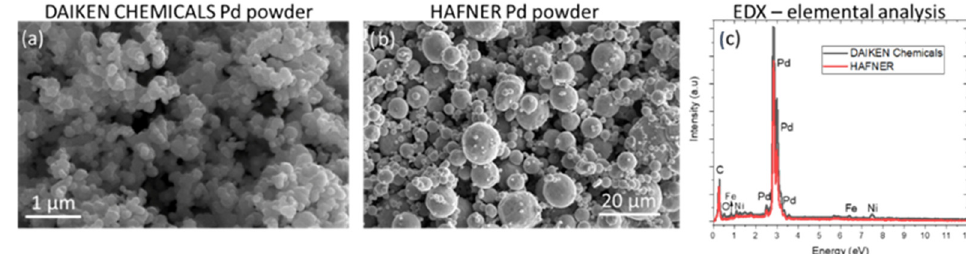
Figure 2. SEM images of the powders using 20 kV, 1.6 nA and ETD detector showing the average particle ( a ) Daiken chemicals Pd powder, ( b ) Hafner, and ( c ) EDX analysis of the powders showing their purity.